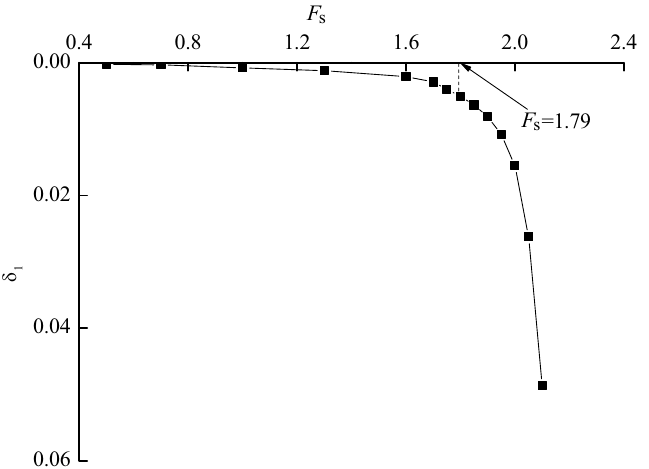
Figure 8. Relationship between F s and δ 1 .